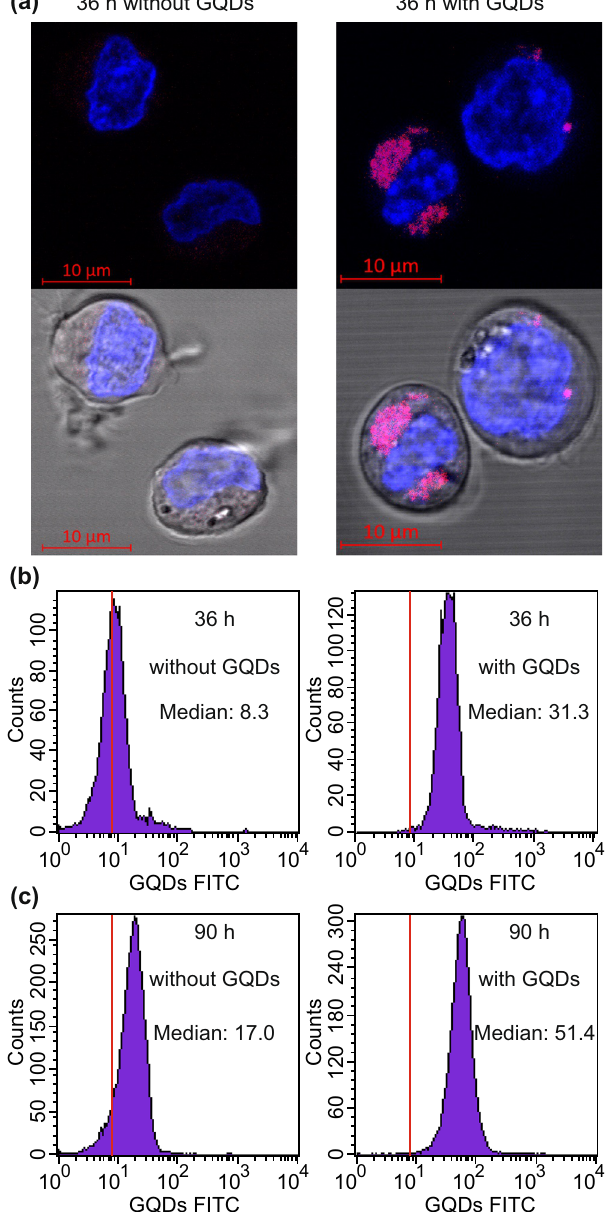
Figure 4. ( a ) Confocal fluorescence microscopy images of living cells cultured for 36 h without GQDs (left) and with GQDs (right) as observed (top row) and merged with the bright field images (bottom row). The stained nuclei are represented in blue while GQDs appear in purple. The fluorescence intensity distributions as determined by flow cytometry after 36 and 90 hours of cultivation are shown in ( b , c ) respectively. Here, the left parts show the evolution just in the culture medium and the right parts that one in the presence of the